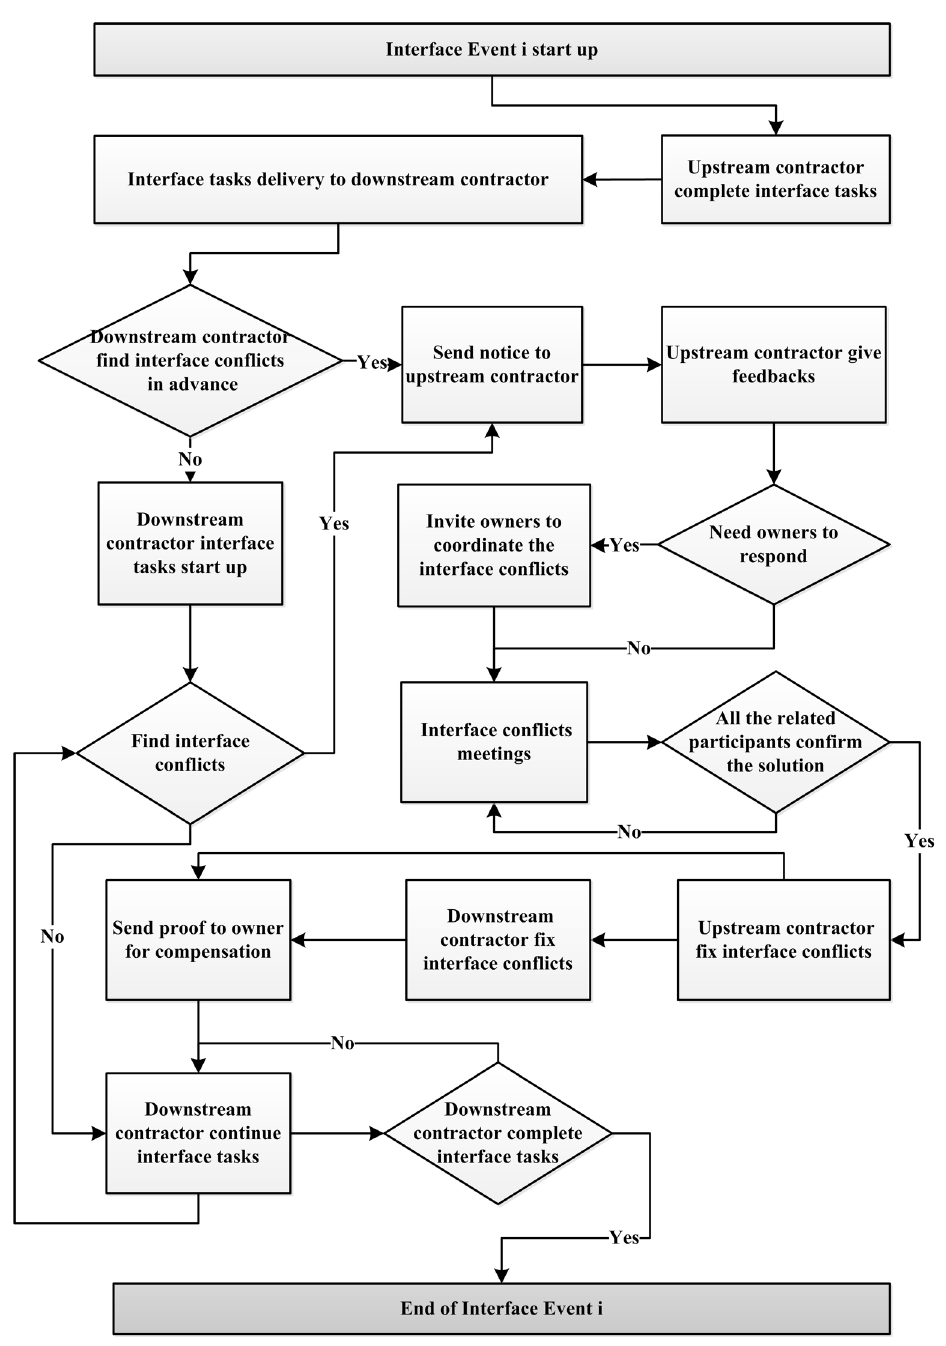
Fig. 2. Status quo interface event